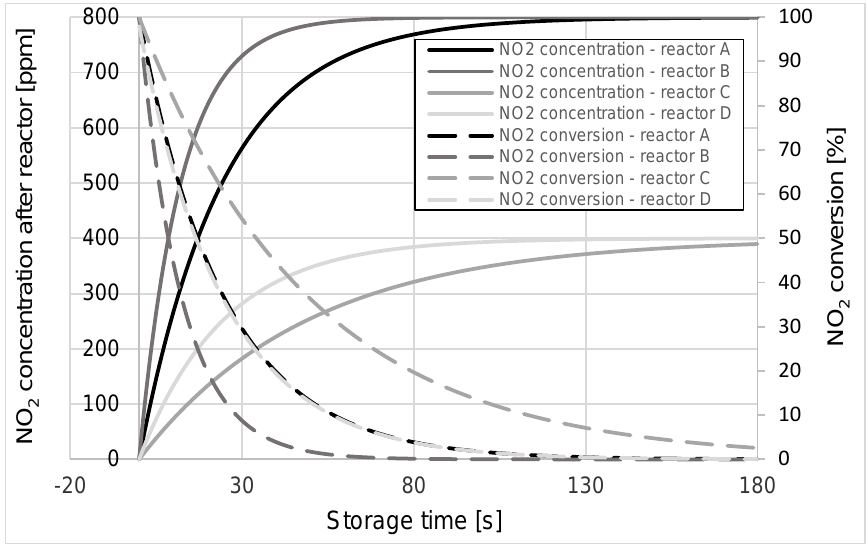
Figure 3 . Changes in NO 2 concentration and its conversion during the storage process in A, B, C, and D reactors at the operating temperature of 200 °C .